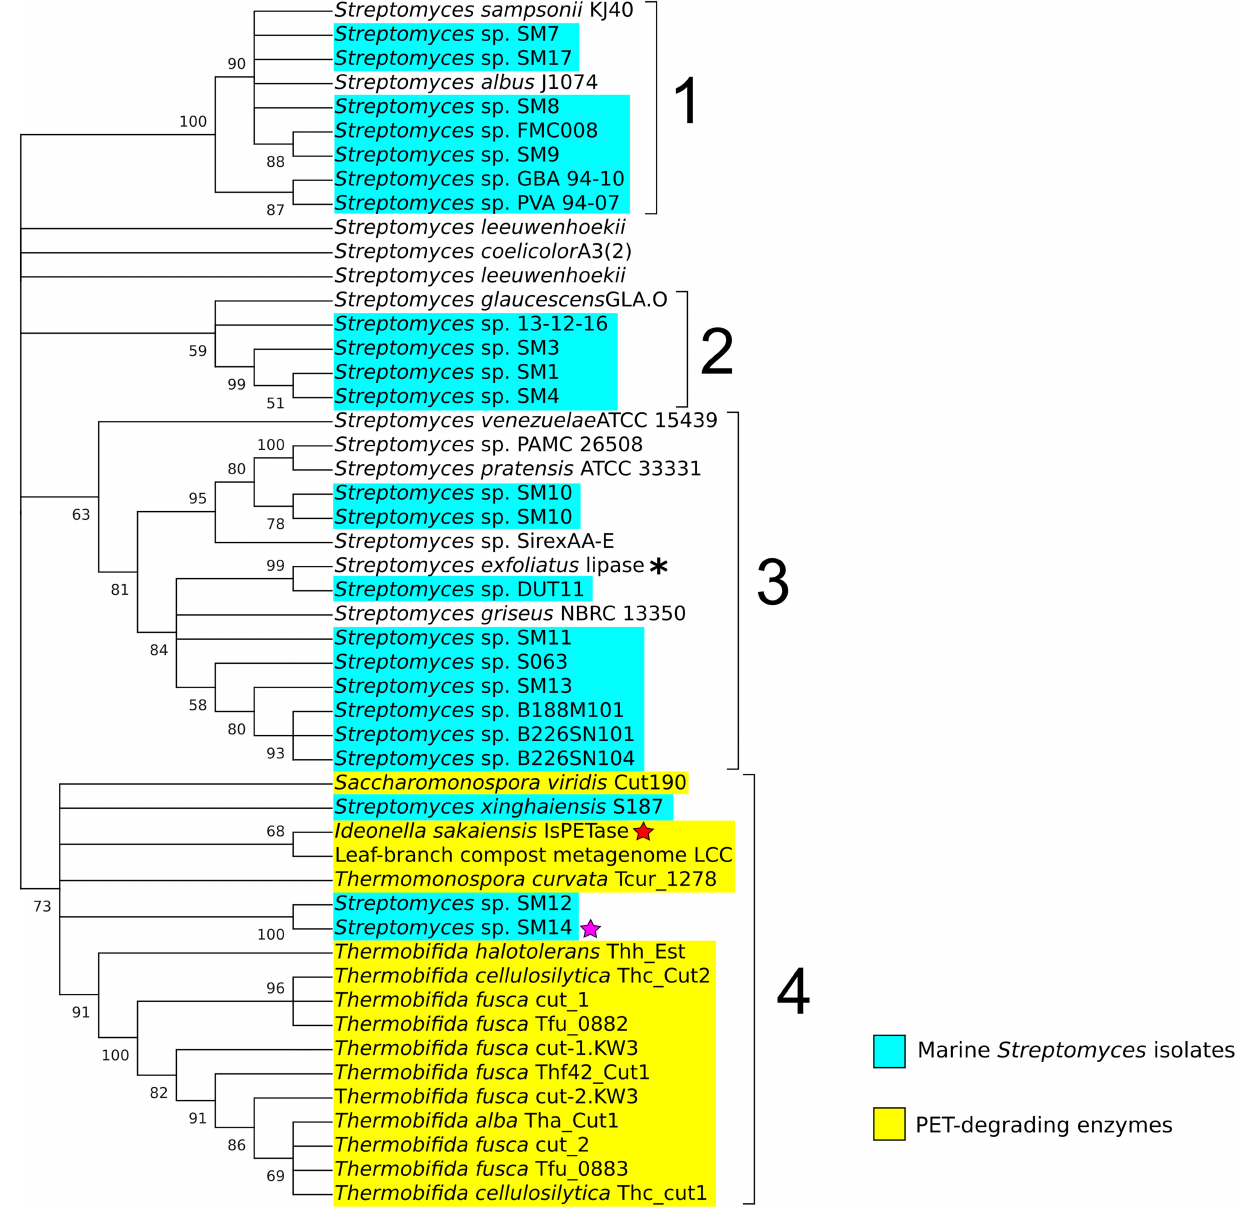
FIGURE 2 | Phylogenetic tree of potential PETase homologs identified in the Streptomyces genomes, including terrestrial and marine (highlighted in cyan) Streptomyces isolates. The enzymes with known PET-degrading activity are highlighted in yellow. The red star indicates the Ideonella sakaiensis IsPETase, the purple star a PETase-like protein from the Streptomyces sp. SM14, and the asterisk the lipase from Streptomyces exfoliatus . The numbers in the branches indicate the percentage of bootstrap replicates (with a 50% cut-off from 500 replicates) in which the associated taxa clustered together. Repeated strain names indicate the presence of multiple proteins in their respective genomes that shared similarity with the reference PETases